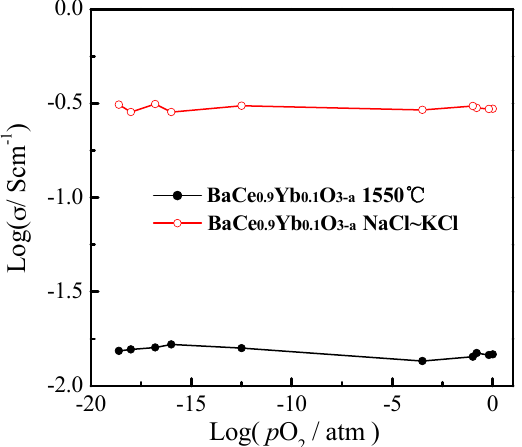
Figure 5. The conductivities of BaCe 0.9 Yb 0.1 O 3 −α (1550 °C) and BaCe 0.9 Yb 0.1 O 3 −α -NaCl~KCl as a function of p O 2 at 700 °C.